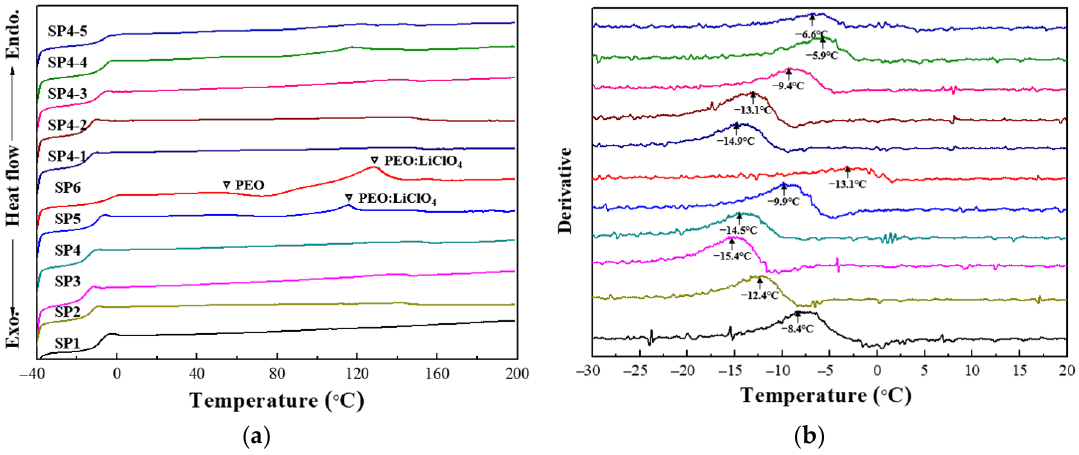
Figure 2. DSC ( a ) and derivative ( b ) curves of solid polymer electrolyte samples.